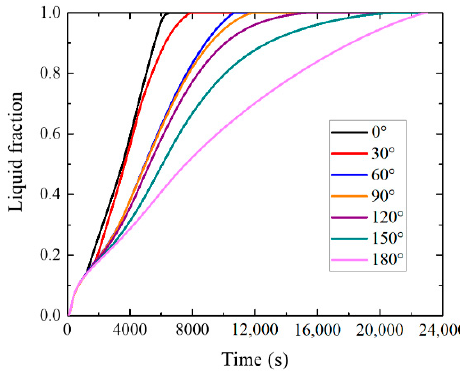
Figure 16. The variation of liquid fraction at different inclination angles.